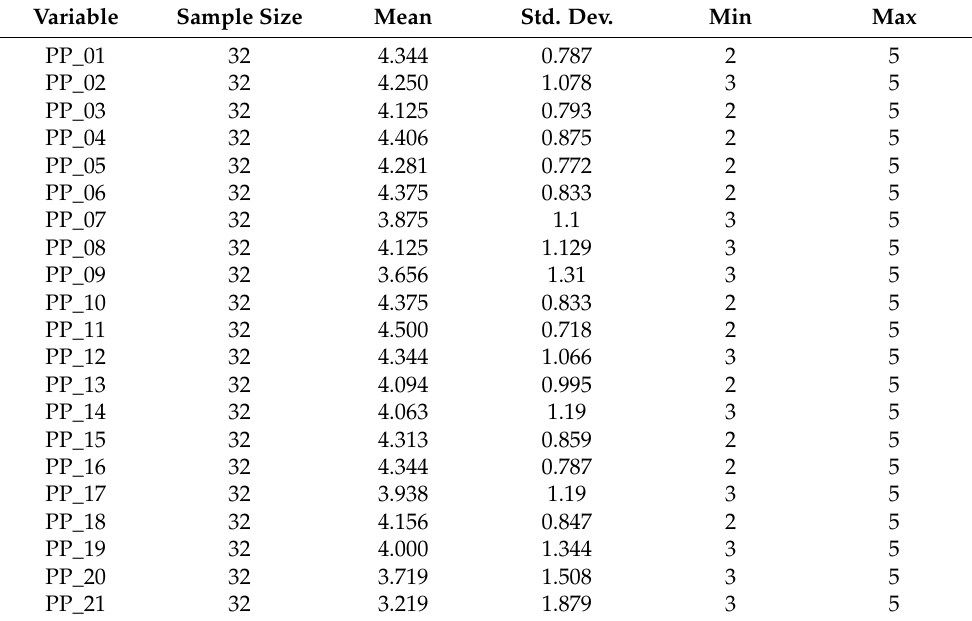
Table 15. Descriptive statistics by pedagogical practices’